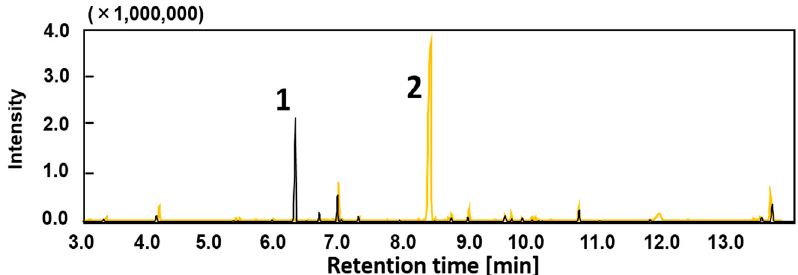
Figure 3. Conversion of benzoylformate by E. coli cells carrying pKSBzf1 (black line) or E. coli cells carrying pBluescriptKS+ (yellow line). Peak 1, benzoic acid; 2, benzoylformic acid. The products were derivatized with MSTFA and identified comparing the retention time and mass spectra of authentic trimethylsilylated standards. m/z values of each peak are listed in Supplemental Table S1.